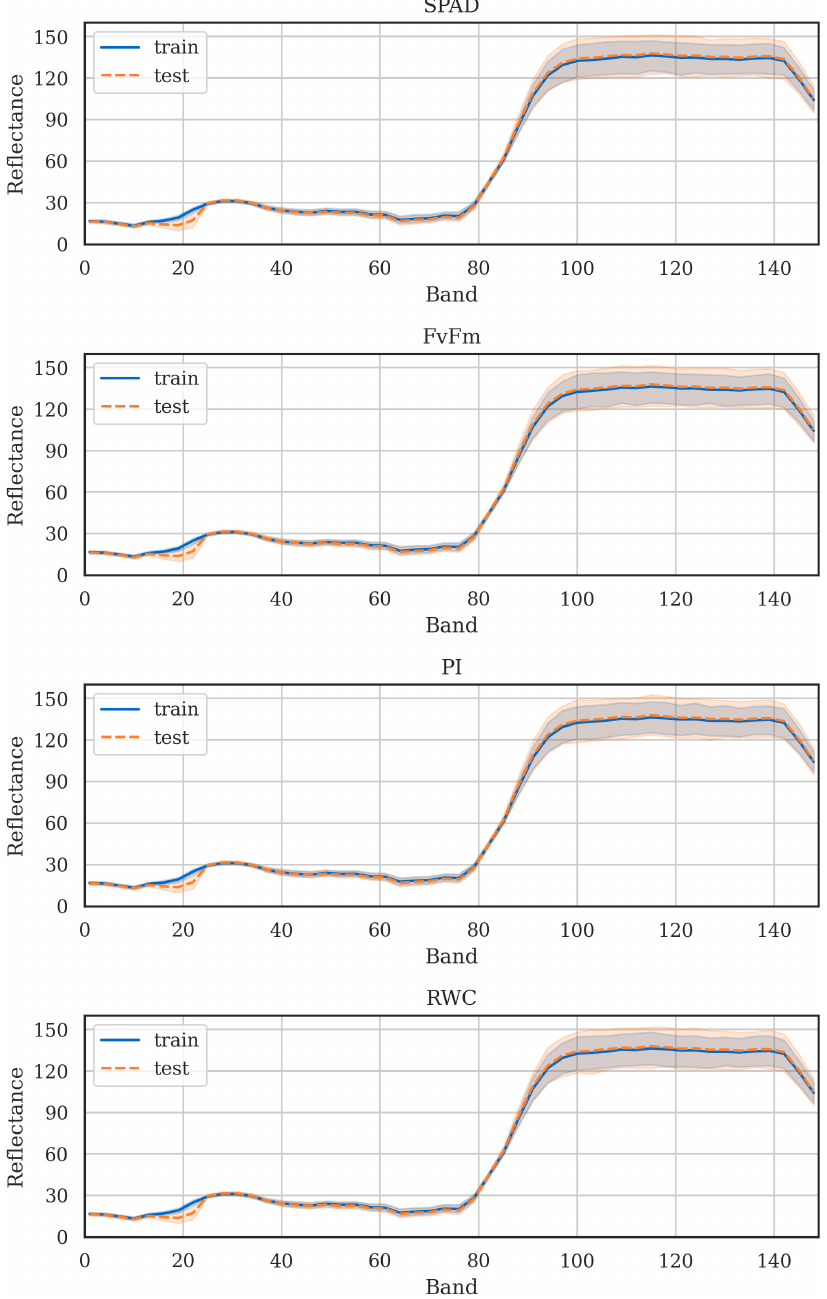
Figure 4. Spectral characteristics of all HSIs in the training and test sets. The mean spectral curves are rendered as blue and orange (dashed) lines for the training and test set,